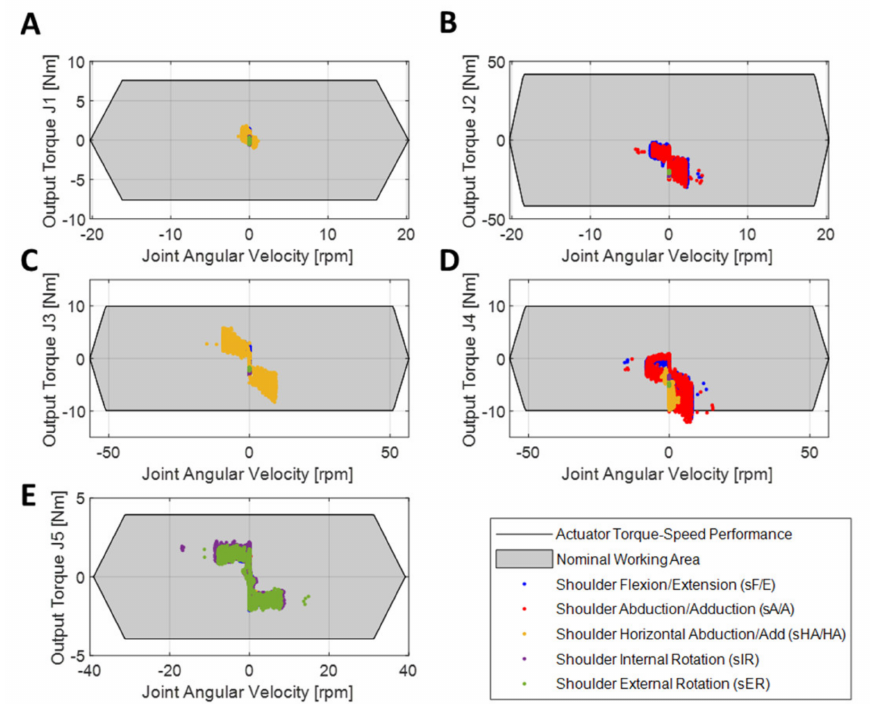
Figure 13. Experimental evaluation of the Float exoskeleton performances with respect to the actuator torque-speed envelopes for each joint under all the Kinematic mode exercises. ( A – E ) Torque speed for